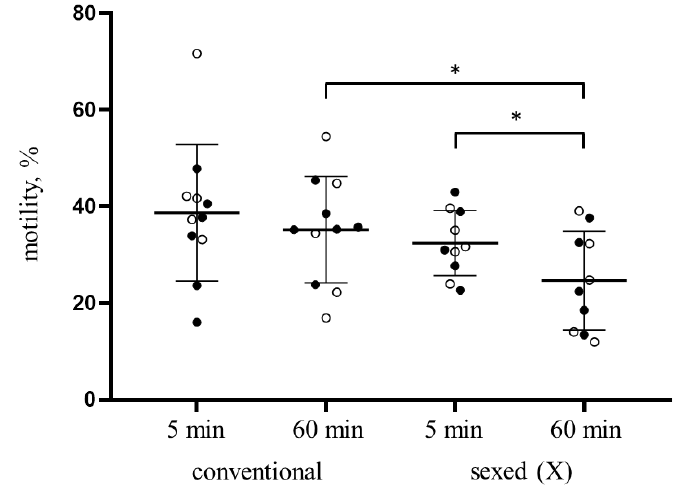
Figure 3. Percentage of motile sperm among the total number of gametes at the beginning (5 min post-thawing) and at the end (60 min post-thawing) of incubation at 37 °C in frozen-thawed samples of sexed (X spermatozoa) and conventional bovine sperm derived from the same bull (white circles) or from different animals (shown with black dots). * p -value < 0.05. The bold line corresponds to mean value and error bars indicate standard deviation.